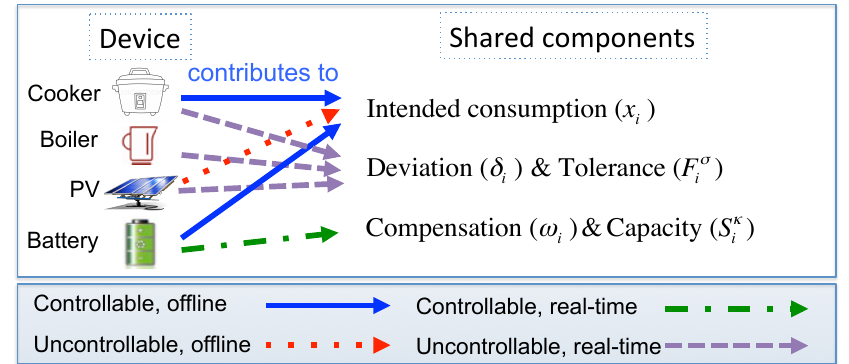
Figure 8. Device aggregation